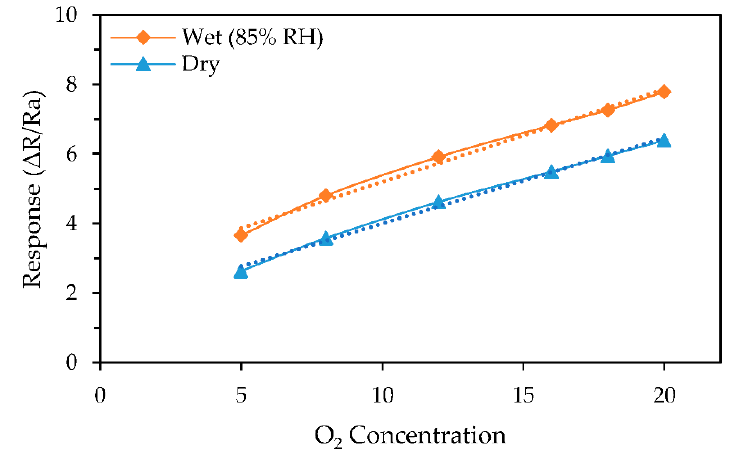
Figure 3. Sensor responses toward various oxygen concentration in dry and wet air (85%